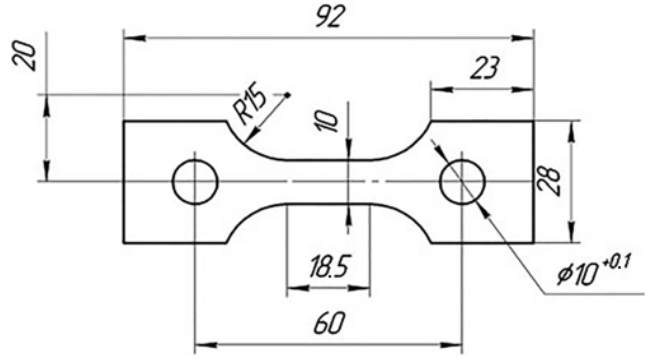
Figure 1. Test specimen (dimensions indicated in mm).